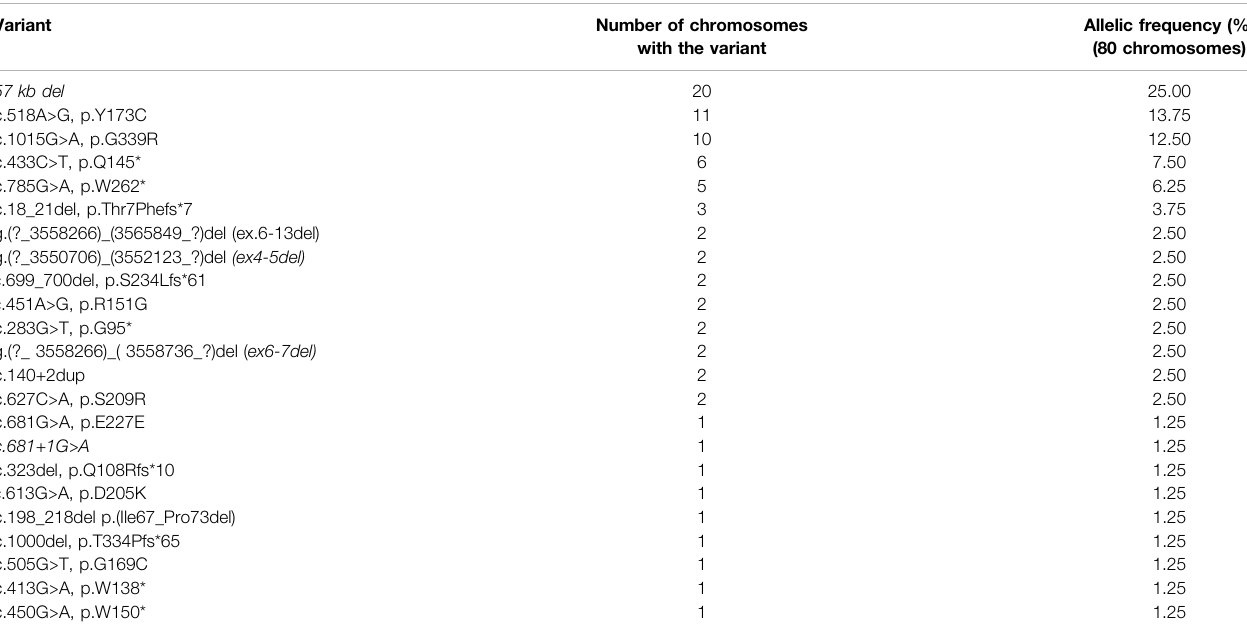
TABLE 1 | Allelic frequencies of CTNS ( NM_001031681.2 ) GRch37 variants. Variant Number of chromosomes